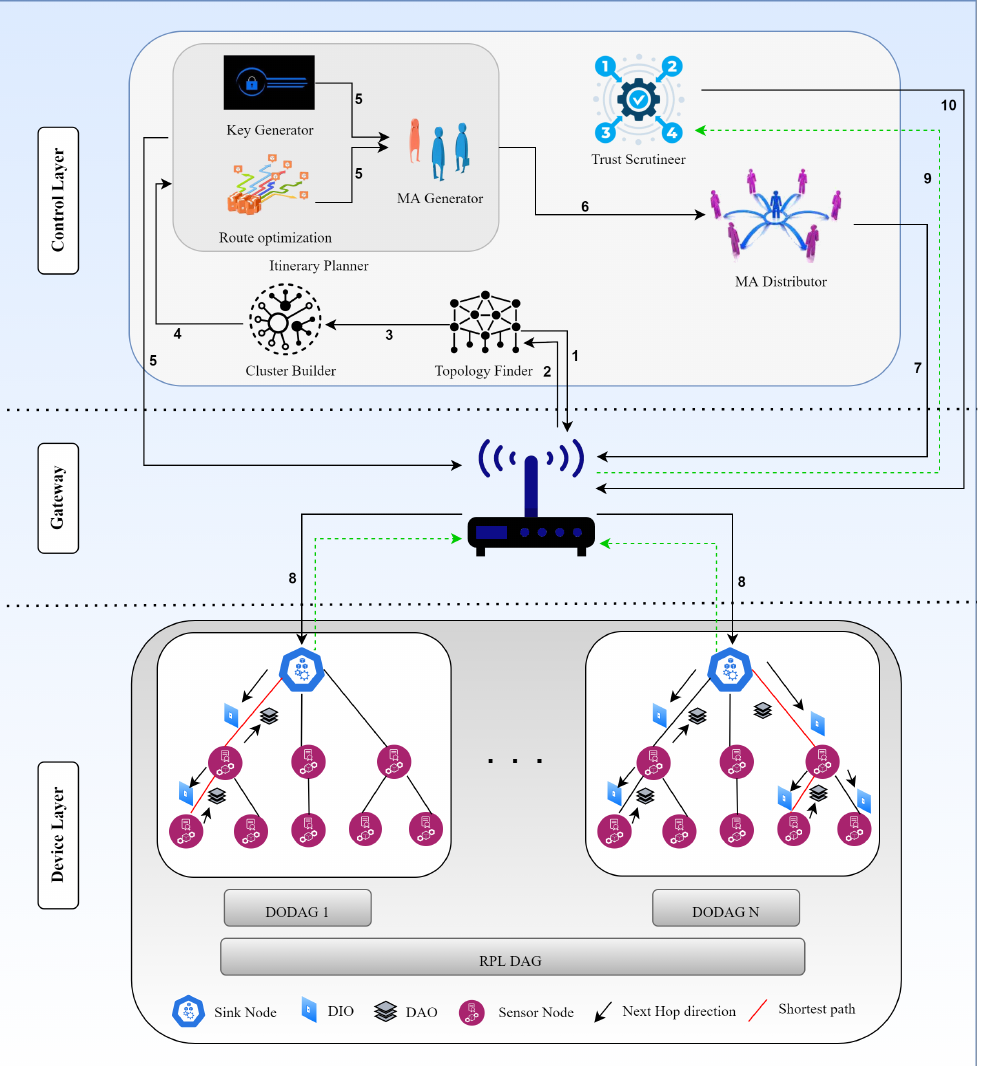
Figure 3. Workflow of the proposed MMTM-RPL framework. The numbers in the figure represent the steps taken for malicious node detection and